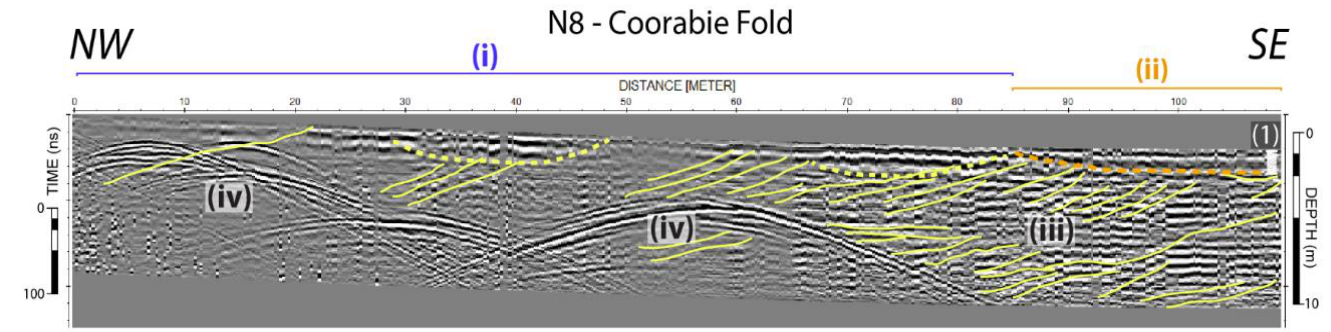
Figure 10. ( A ) Full GPR transect N7. Interpreted reflectors are shown in yellow; ( B ) Orthophoto showing the transect in relation to the surrounding landscape. The fold scarp is imaged by a grey- green ground color as is the ridge towards the start of the transect, visible in the topography along the GPR transect and as grey-green patch in ( B ) below the white arrow; (i): zones of stronger reflec- tor packages, (ii): zone underneath slightly elevated terrain with strong, discontinuous reflectors, with increased penetration depth, interrupted by numerous diffractions; (iii): ‘sideswipe’ from ad- jacent fenc ing; (iv): possible trench producing ‘ringing’ at the edges.